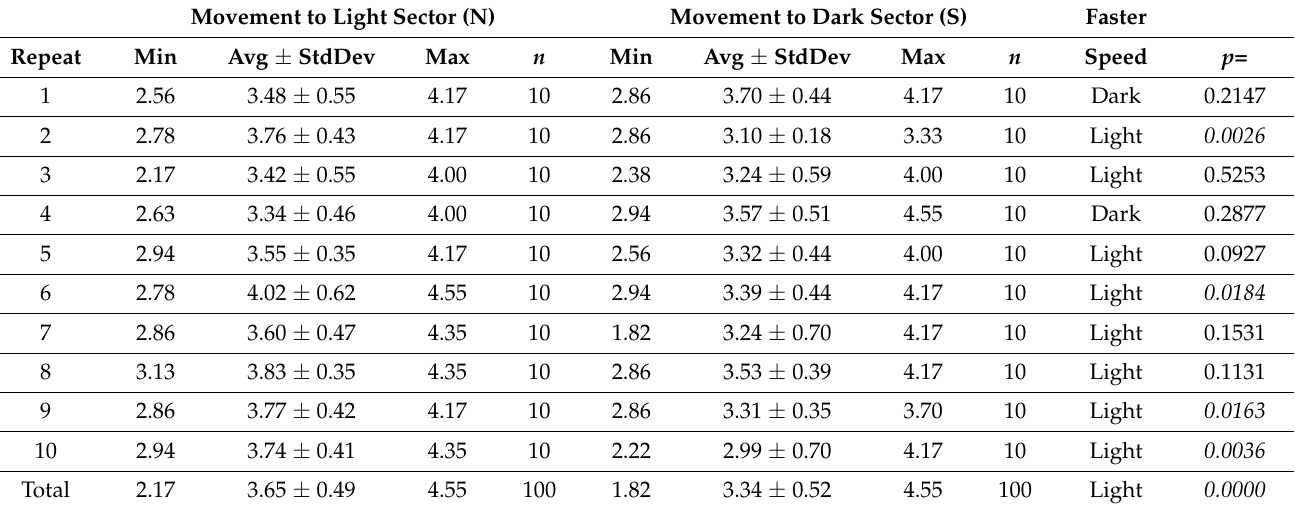
Table 3. Experiment #1. Crawl speeds of Coccotrypes dactyliperda (in mm/s) towards light and dark sectors ( p value based on two-tailed paired t -test, significant value show in italics). Movement to Light Sector